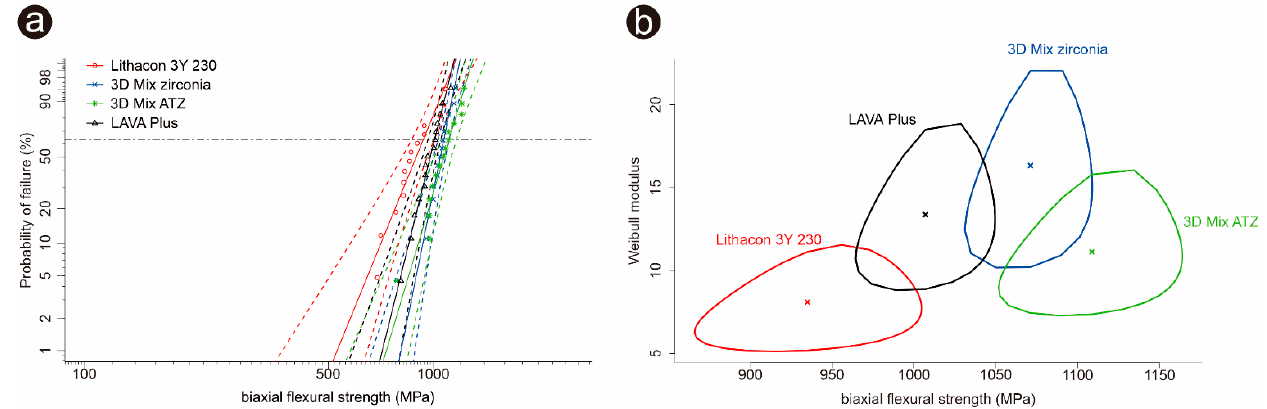
Figure 3. Summary of the Weibull analysis. ( a ): Weibull plots for the 3Y-TZPs and ATZ investigated. ( b ): Weibull contour plots (95% confidence intervals) for 3Y-TZPs and ATZ. Weibull modulus and characteristic strength of each ceramic grade are presented with “×” inside of the contour plots. Table 3. Summary of the Weibull biaxial strength analysis.